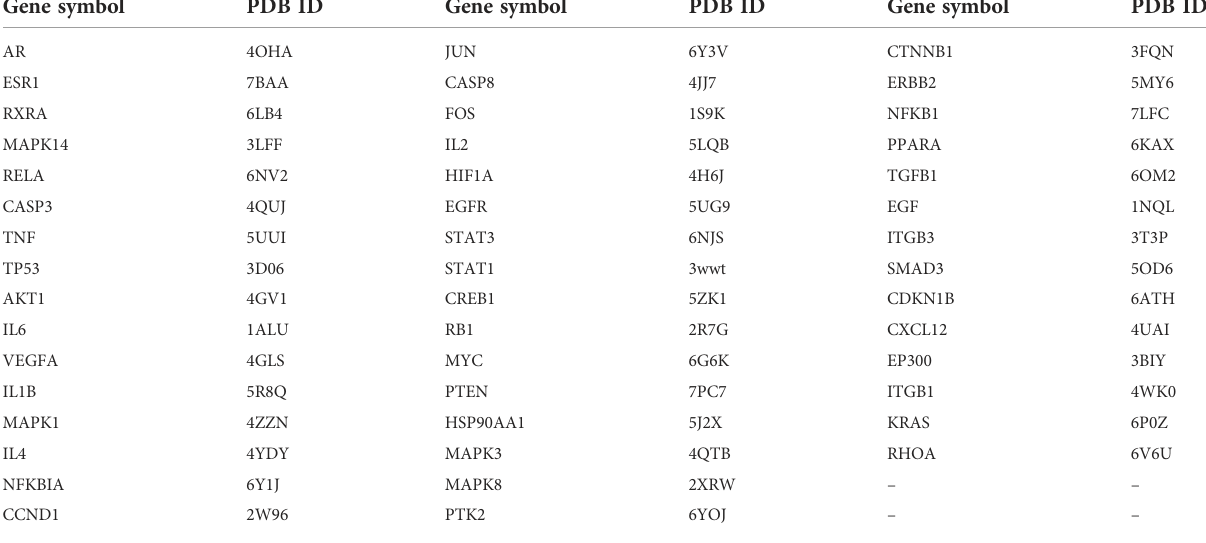
TABLE 1 The PDB IDs for 46